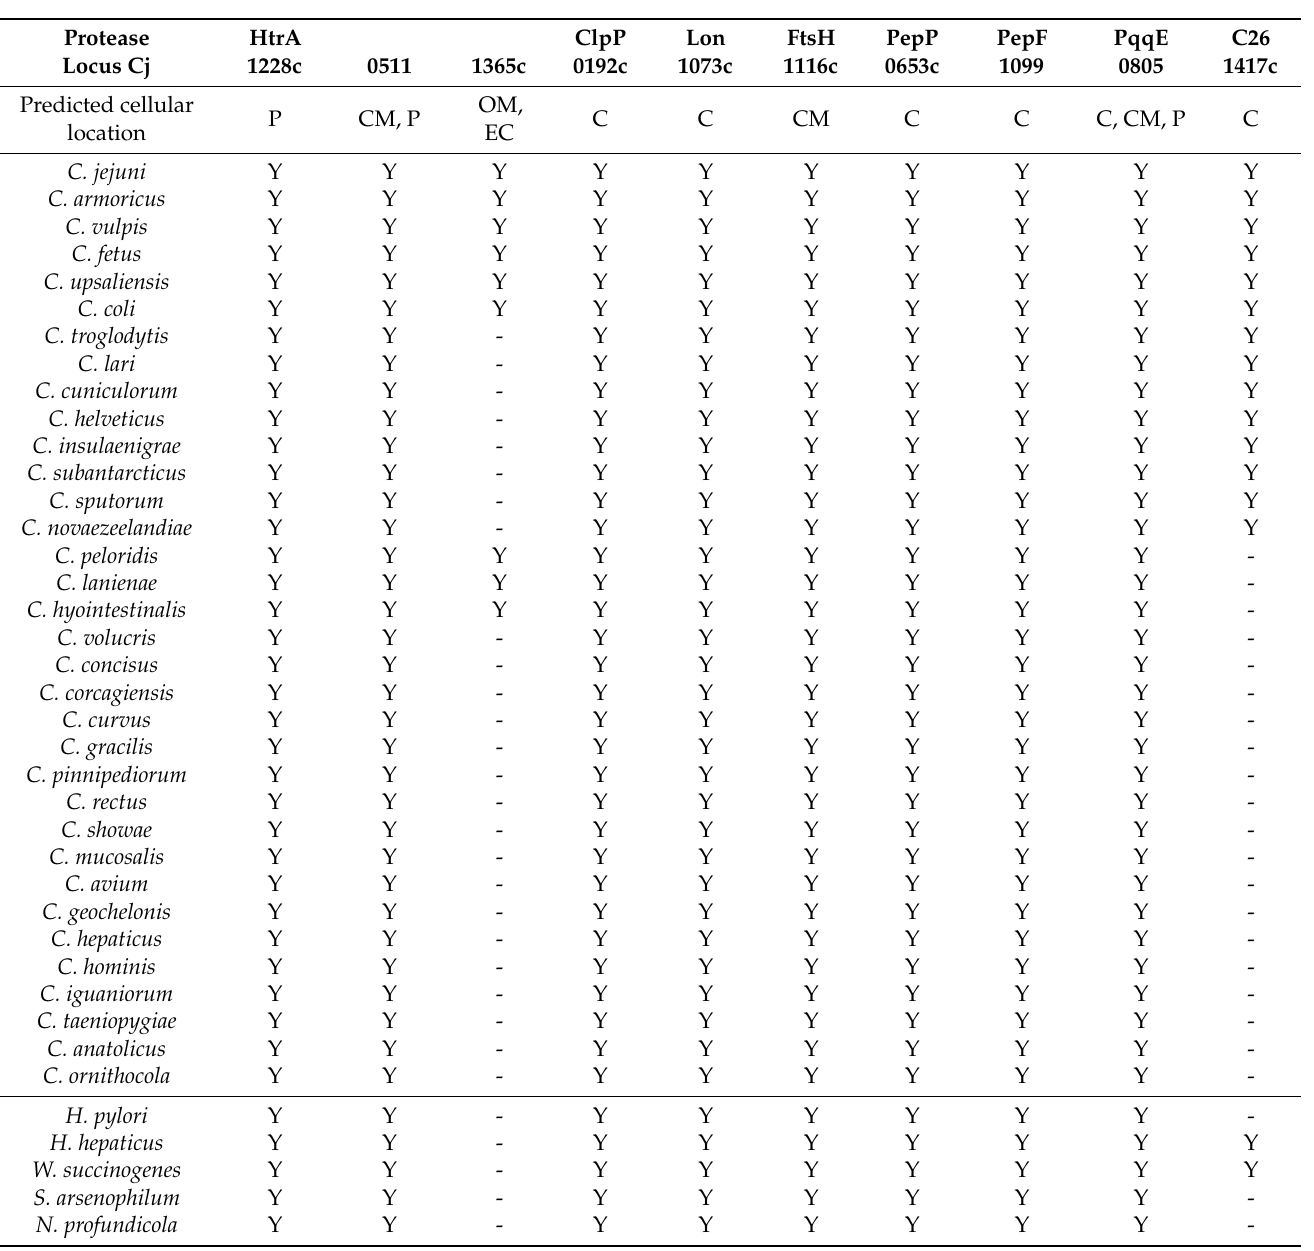
Table 1. Distribution of various proteases within the Campylobacter genus and in other ε -Proteobacteria. Protease Locus